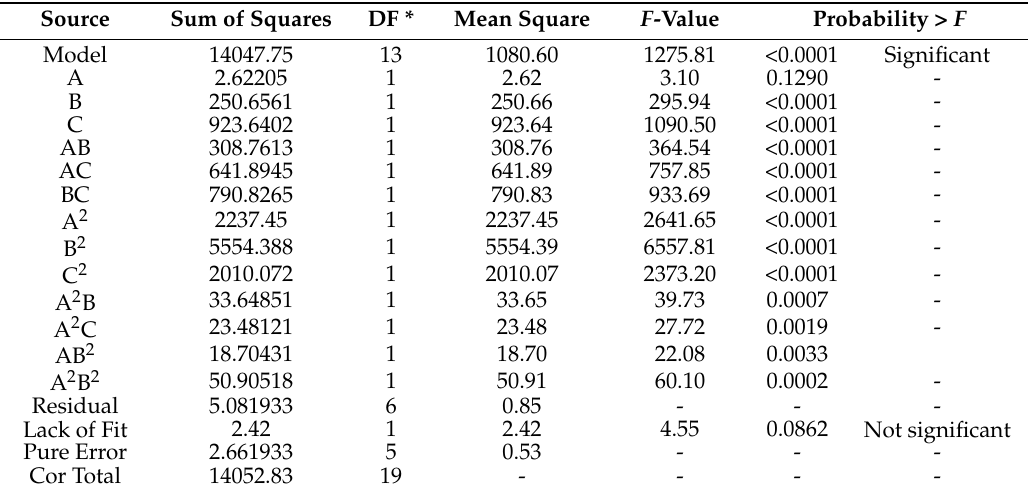
Table 2. ANOVA table for the quadratic